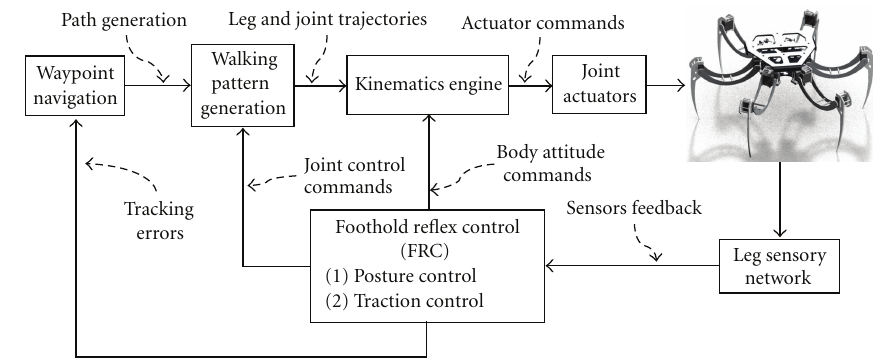
Figure 5: Overall control system framework.